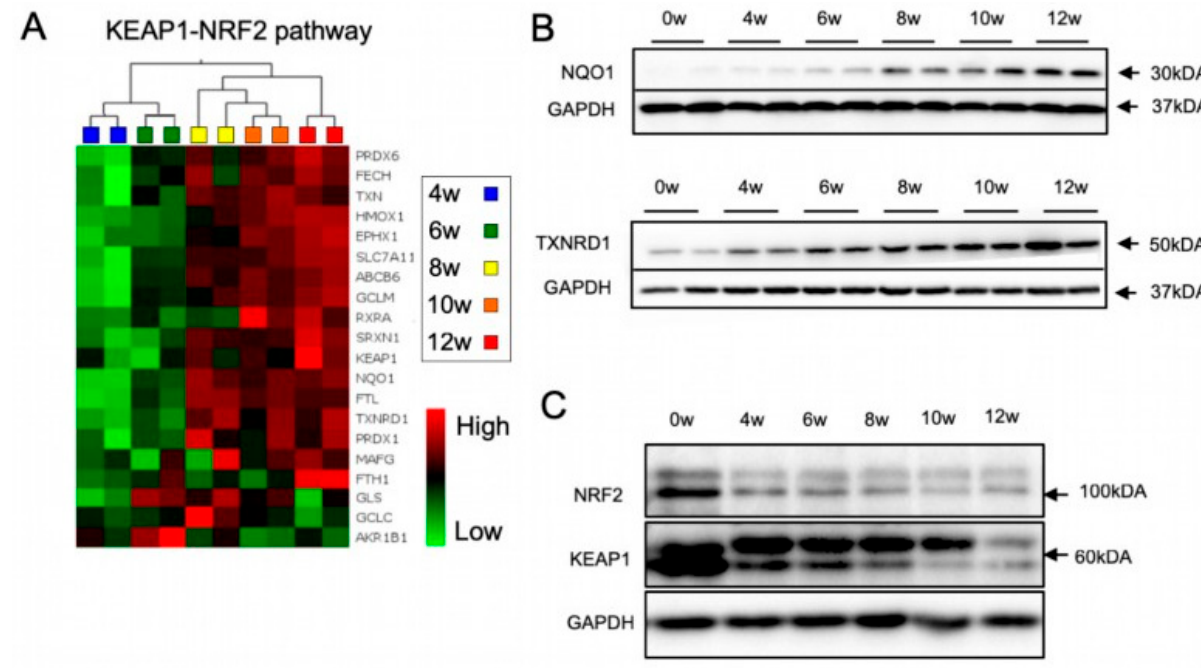
Figure 2. Dynamic regulation of the KEAP1-NRF2 pathway during neural differentiation. ( A ) Heatmaps showing the differential gene expression pattern of known NRF2-pathway specific genes across differentiation of lt-NES cultures. Data were generated using an Affymetrix transcriptome microarray. Expression levels (log2 scale) for each gene were averaged across samples and differences are depicted as standard deviation changes. Clustering analysis was performed by multigroup comparison ( n = 2). ( B , C ) Protein expression of NRF2 pathway components was assessed by immunoblot analysis at indicated weeks (w) of lt-NES cell differentiation. ( B ) Protein levels of the NRF2 downstream targets NQO1 and TXNRD1 increase during neural